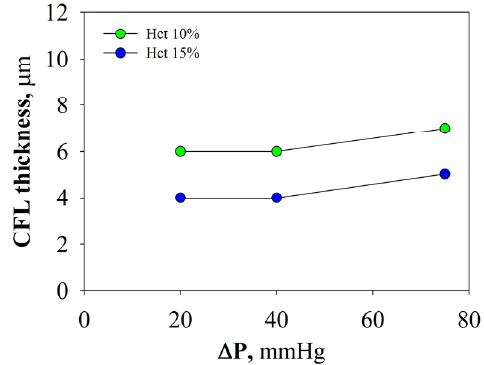
Figure 6. CFL thickness for different shear rates at 10% and 15% Hct. (For interpretation of the references to color in this figure legend, the reader is referred to the web version of this article).